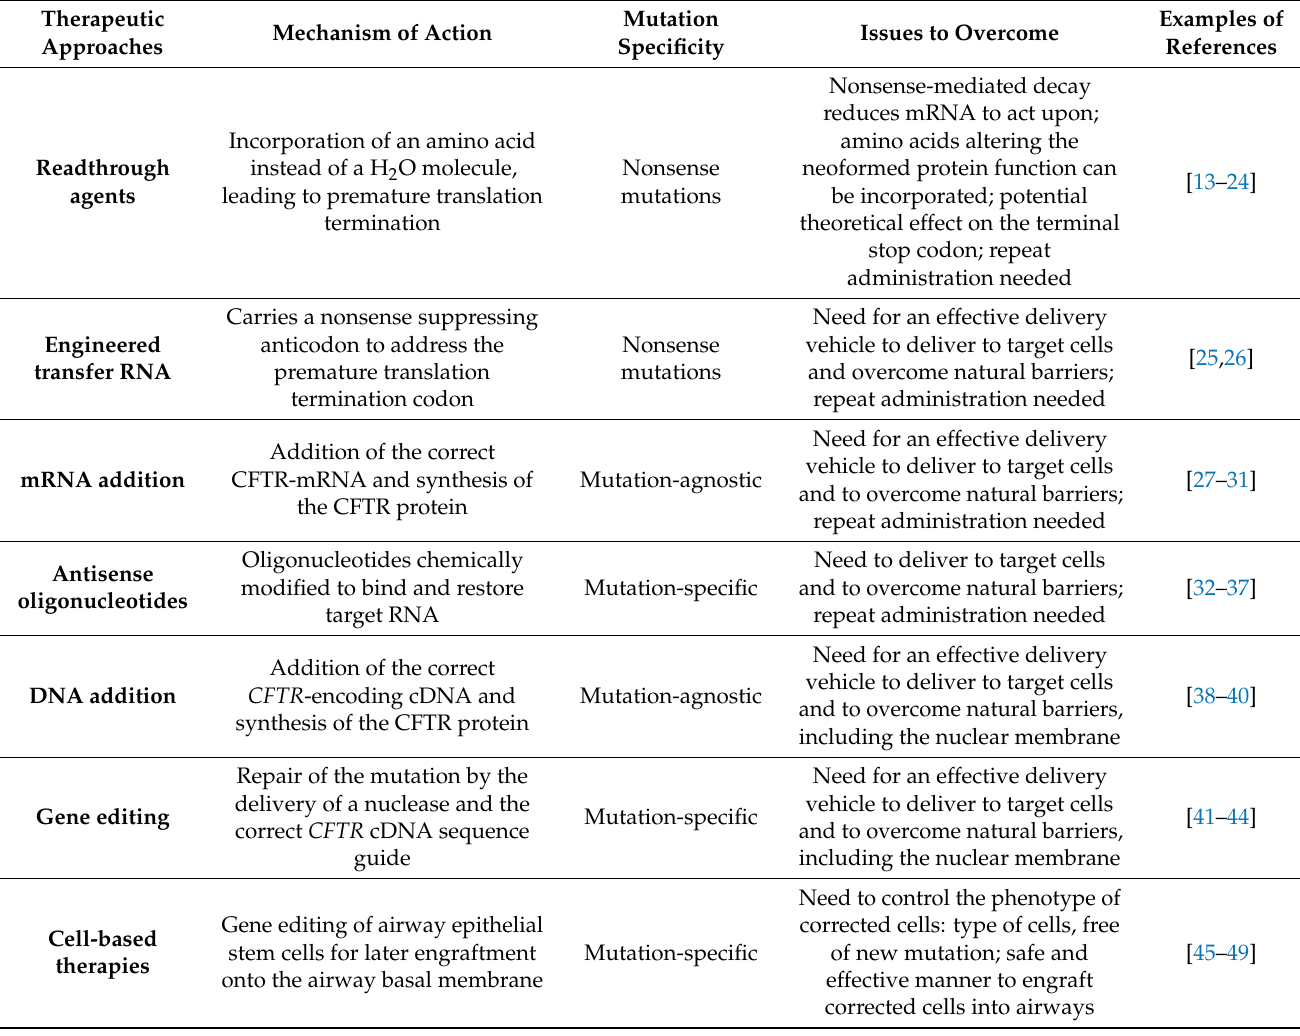
Table 1. Summary of the different therapeutic approaches to treat patients with cystic fibrosis bearing mutations non- responsive to current CFTR modulators (see text for